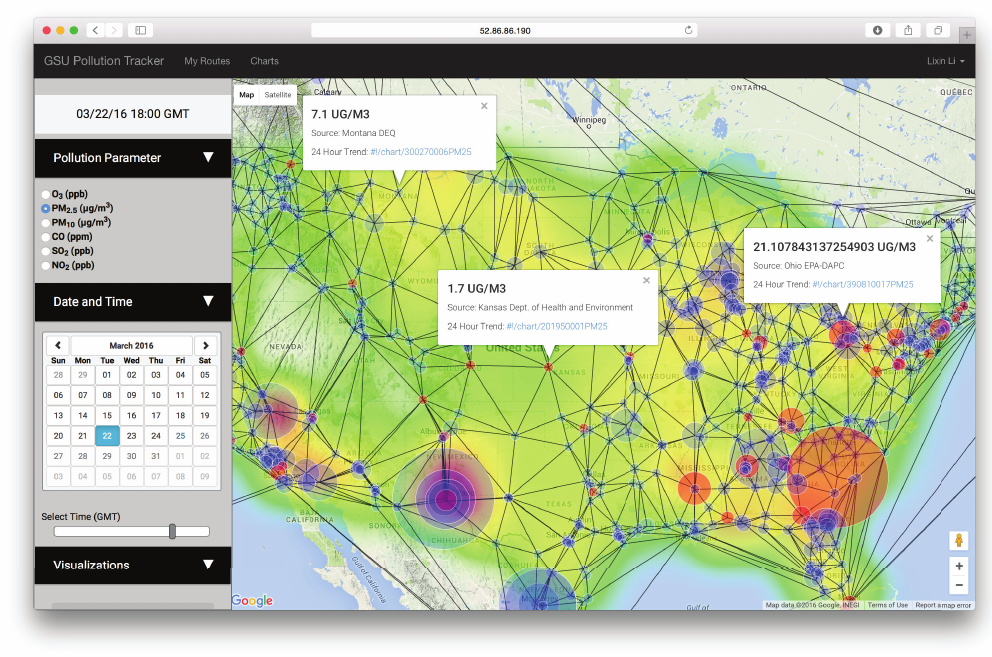
Figure 9. Web application. Rendering of PM 2.5 concentrations across the contiguous U.S. on 22 March 2016 at 18:00 GMT, including intensities at known measurement sites and the resultant triangulations used in the shape function (SF)-based interpolation